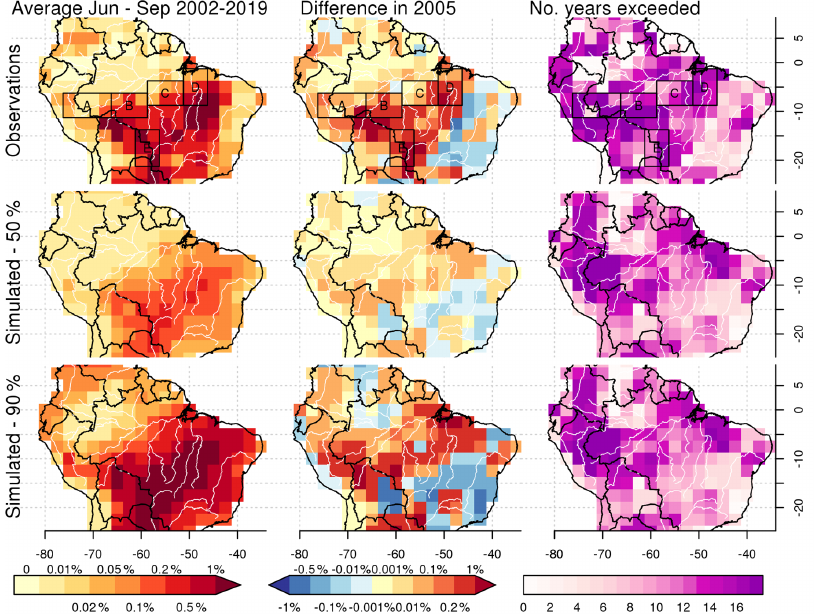
Figure C1. Same as Fig. 3 but for June–September annual average compared to 2005.